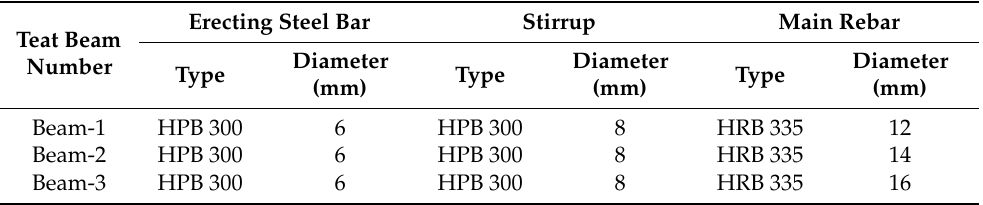
Figure 2. Dimension of the reinforcement basalt fiber polymer-modified RPC beam (mm). The types and diameters of erective steel bars, stirrups, and main rebar of each test beam are shown in Table 2. In each test beam, two HPB300 steel bars with a diameter of 6 mm were used as erecting steel bars; ten HPB300 steel bars with a diameter of 8 mm were used as stirrups; two HRB335 rebar with a diameter of 12 mm, 14 mm, and 16 mm respectively were used as the main rebar. Table 2. Types and diameters of steel bars in test beams.